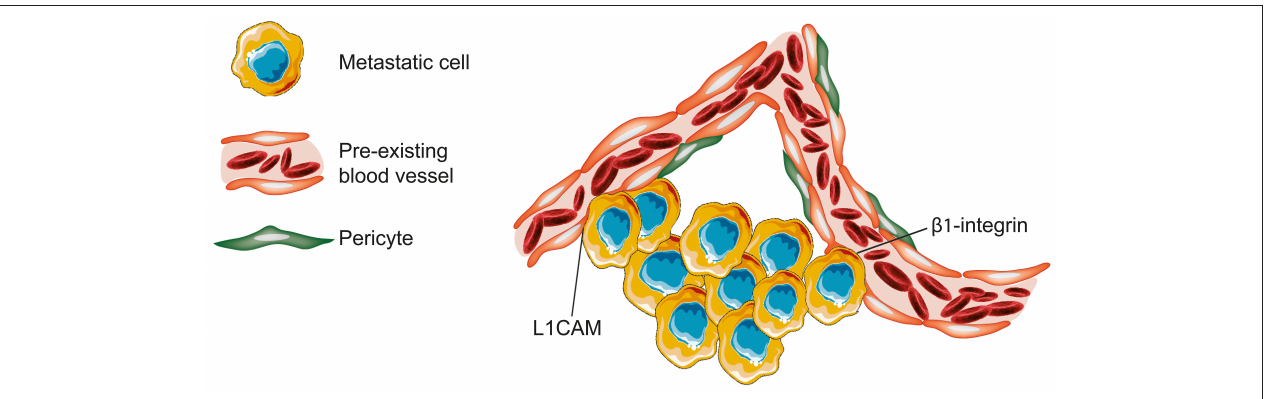
FIGURE 6 | Brain—metastases. In brain metastases, tumor cells can attach to the vascular basement membrane via β 1-integrin. The resultant close spatial proximity to vessels allows then the metastatic cells to co-opt the pre-existing blood vessel. In the presented model, non-angiogenic metastatic cells infiltrating the brain tissue are characterized by secretion of neuroserine protease inhibitors and expression of L1CAM. Neuroserpin blocks plasminogen activator and prevents the formation of plasmin. The inhibition of plasmin release into the microenvironment prevents both the death of cancer cells by FAS ligand and the further blockade of L1CAM (Figure created with vectors from Servier Medical Art.